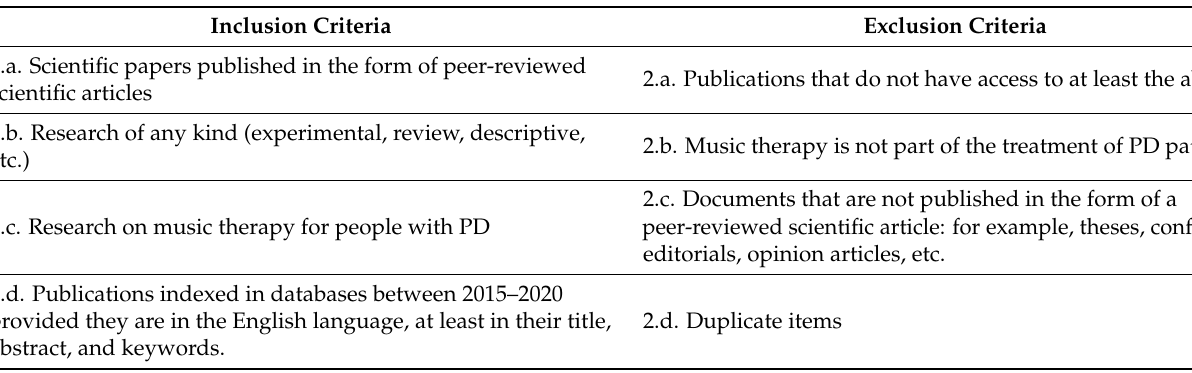
Table 1. Inclusion and Exclusion